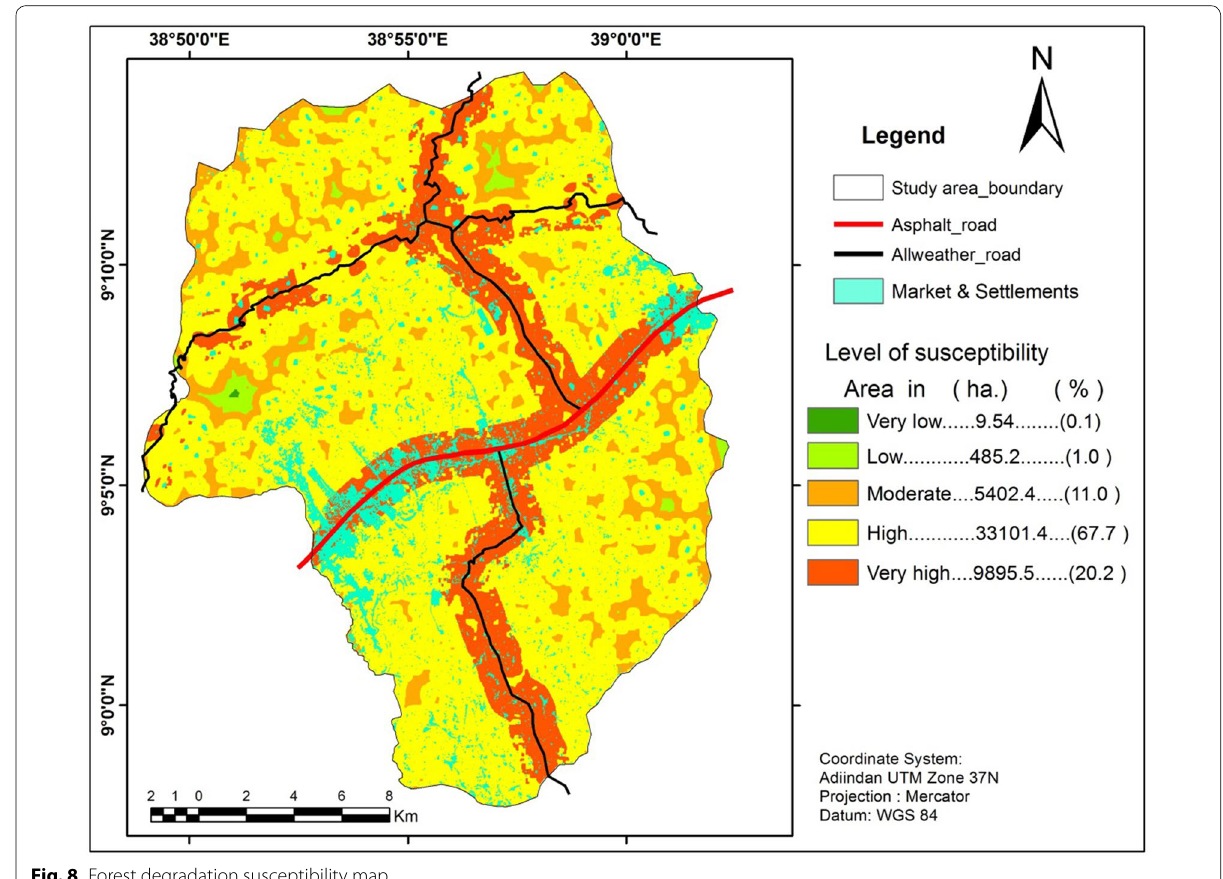
Fig. 8 Forest degradation susceptibility